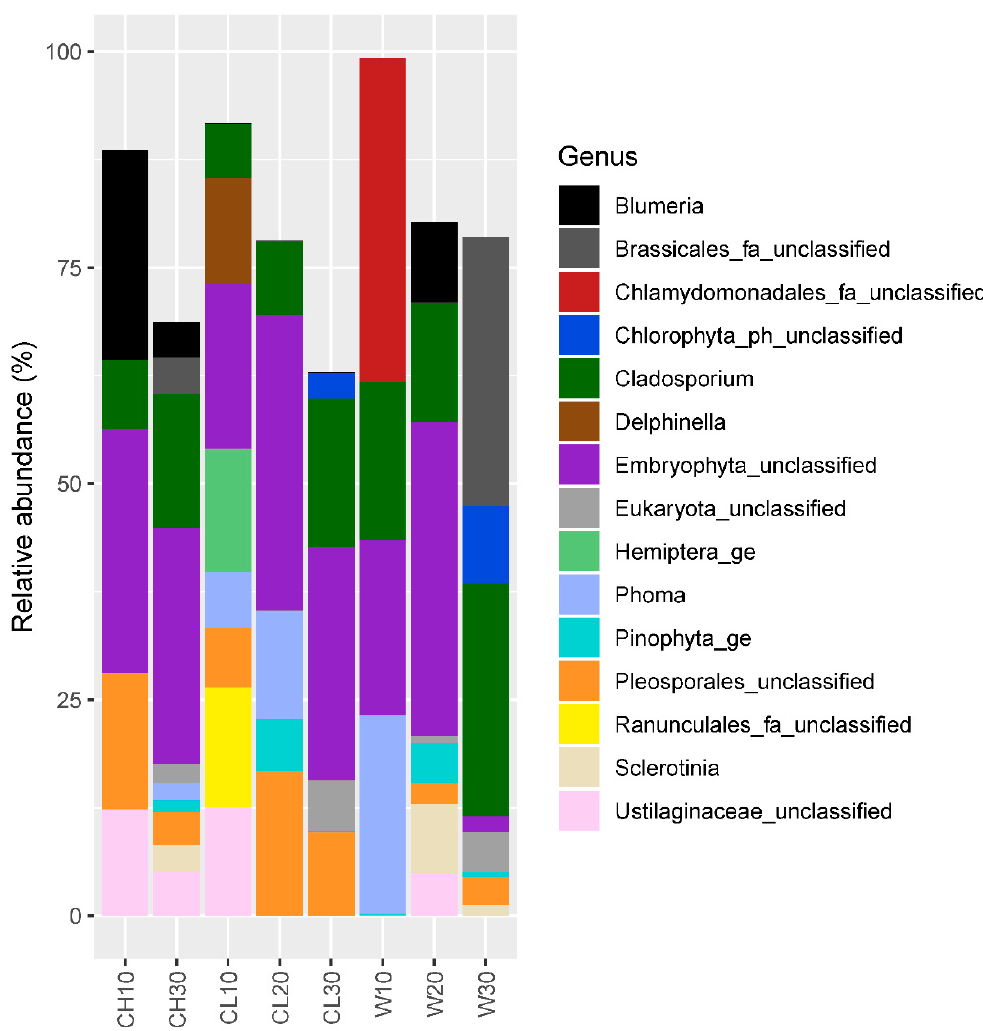
Figure 6. The 15 most abundant eukaryotic genera detected in the samples. Labels CH10 and CH30 indicate the samples collected over Chilbolton at high elevation (ranging from 950–1000 m asl) and with exposure times of 10 and 30 min. CL10, CL20, and CL30 indicate samples collected over Chilbolton at low elevation (ranging from 300–450 m asl) with exposure times of 10, 20, and 30 min respectively. W10, W20, W30 indicates the samples collected over Weybourne (height range of 650–1000 m) with exposure times of 10, 20, and 30 min respectively.